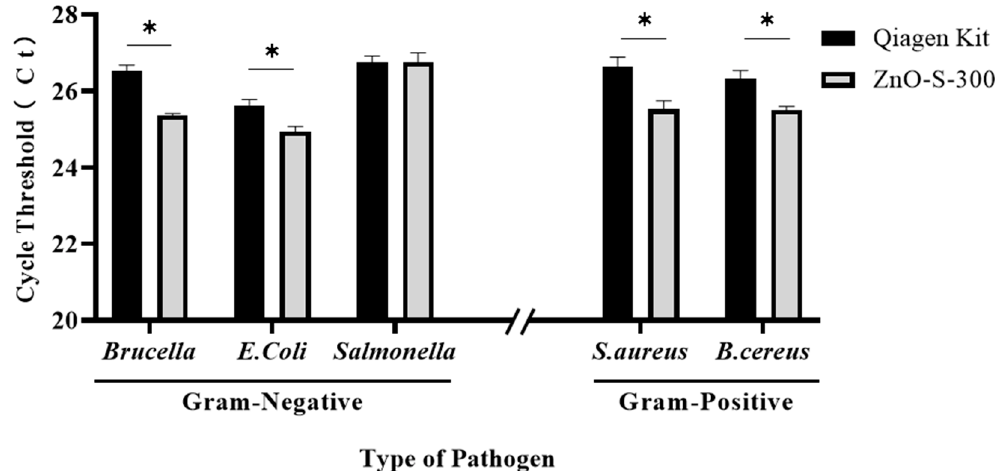
Figure A1. Synthesized ZnO nanoparticles for lysis of bacterial cells. We used 100 μ L (10 4 colony-forming units (CFU)/mL) other bacterial species including Gram-positives ( Staphylococcus aureus and Bacillus cereus ) and Gram-negatives ( Escherichia coli and Brucella ovis ) to test of the performance of the ZnO-based DNA isolation assay. * p < 0.05.